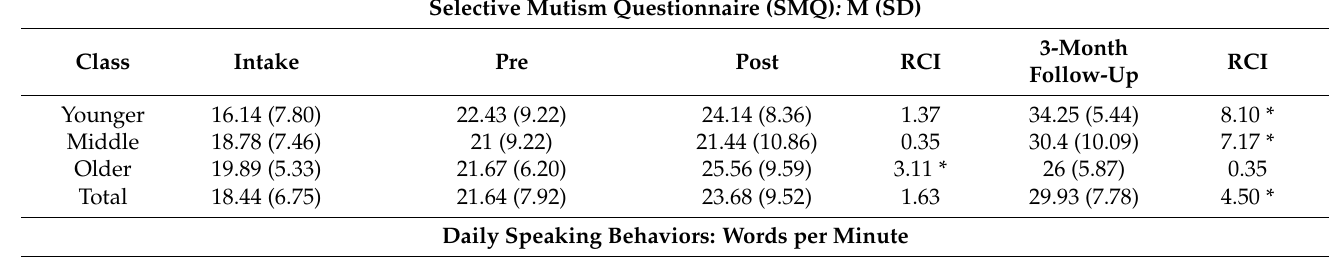
Table 4. Aggregated Speaking Behavior Data as Measured by Parent SMQ